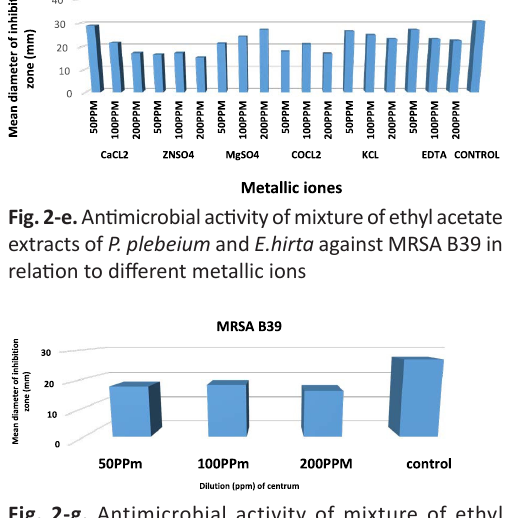
Fig. 2-g. Antimicrobial activity of mixture of ethyl acetate extracts of P. plebeium and E.hirta plant extract of P.plebeium,PP and E. hirta, EH against MRSA B39 in relation to multivitamins capsule